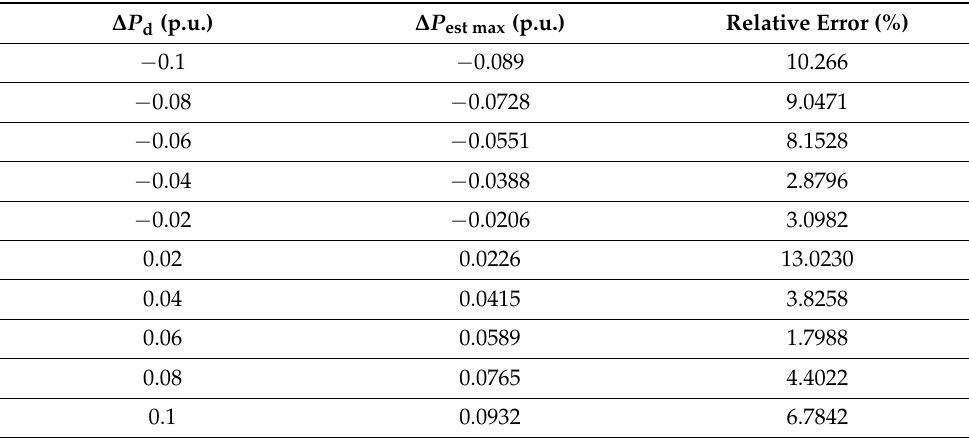
Figure 7. ∆ P est values estimated at different ∆ P d values. Table 1. Disturbance estimation and relative error. ∆ P d